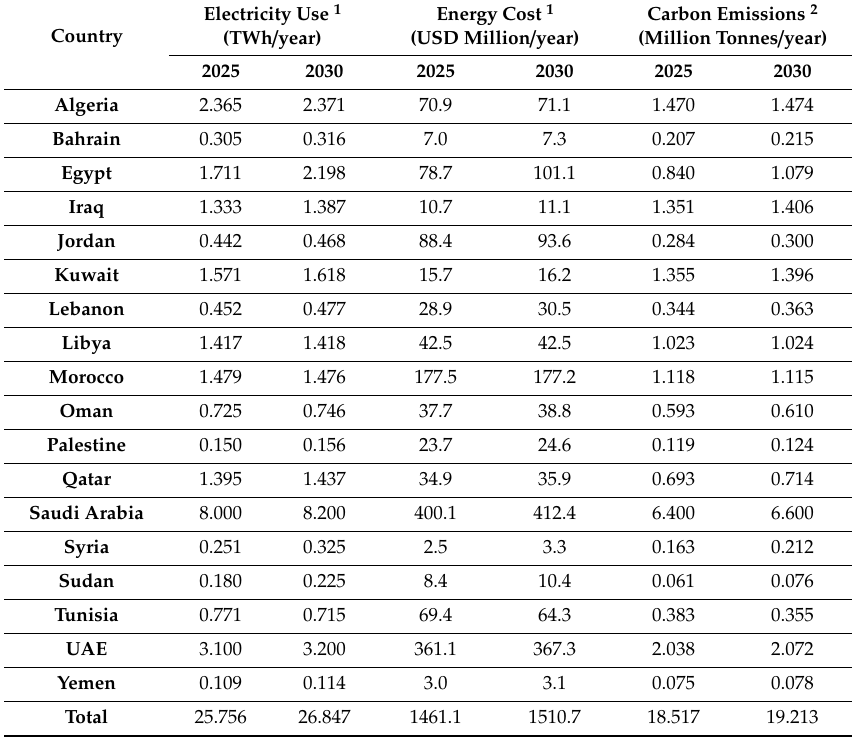
Table 13. Potential annual benefits attributed to lighting minimum energy performance standards (MEPS) in the Arab